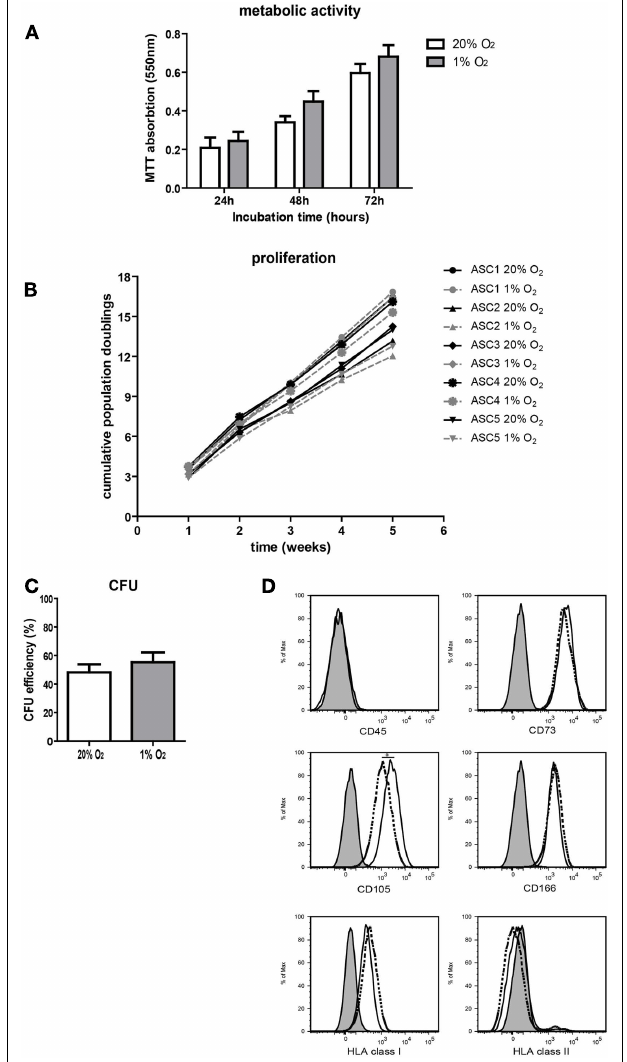
FIGURE 2 | Effect of hypoxia onASC characteristics . (A) ASC metabolic activity measured by MTT assay. Mean with SEM of three different ASC cultures shown. (B) Cumulative population doublings of ASC cultured under normoxic and hypoxic conditions. (C) CFU efficiency of ASC. Mean with SEM of four different ASC cultures shown. (D) Immunophenotype of ASC after culturing for 10days under normoxic and hypoxic conditions. Filled histogram; unstained ASC, solid line; ASC cultured under 20% O 2 , dotted line; ASC cultured under 1% O 2 . *Indicates p <